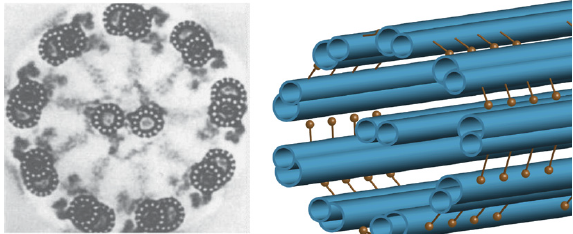
Figure 1. Cross-sectional image and schematic of an axonemal structure (reproduced from [19] with the author’s